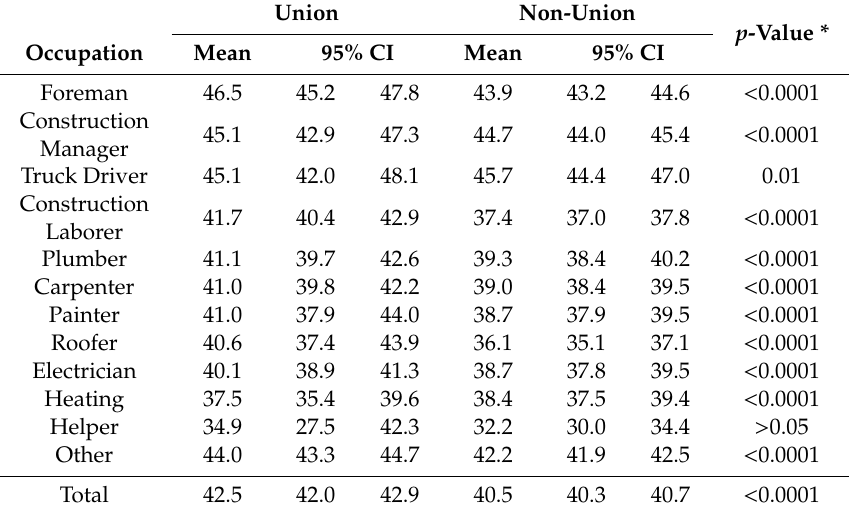
Table 2. Average age of construction workers by occupation, union versus non-union, average of 2015–2017 (wage-and-salary workers).